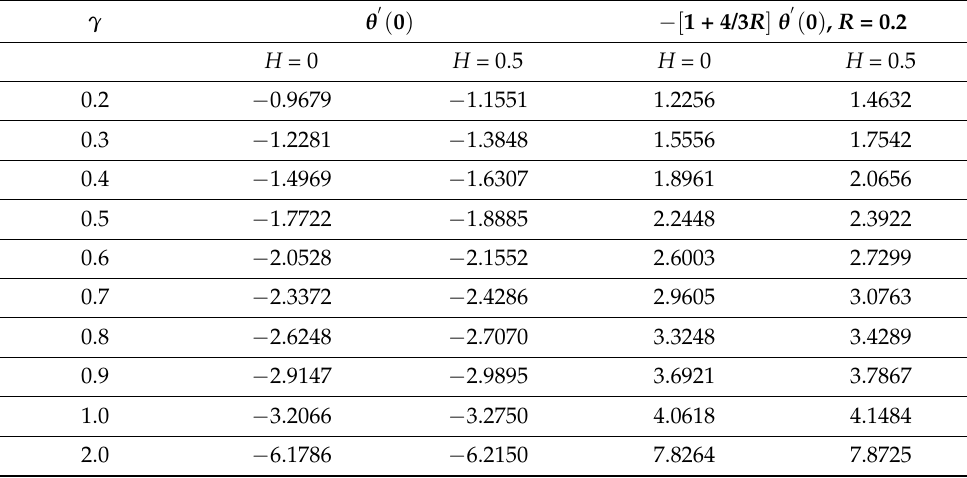
Table 17. Impact of curvature fluid parameter on Nusselt number with and without heat generation.